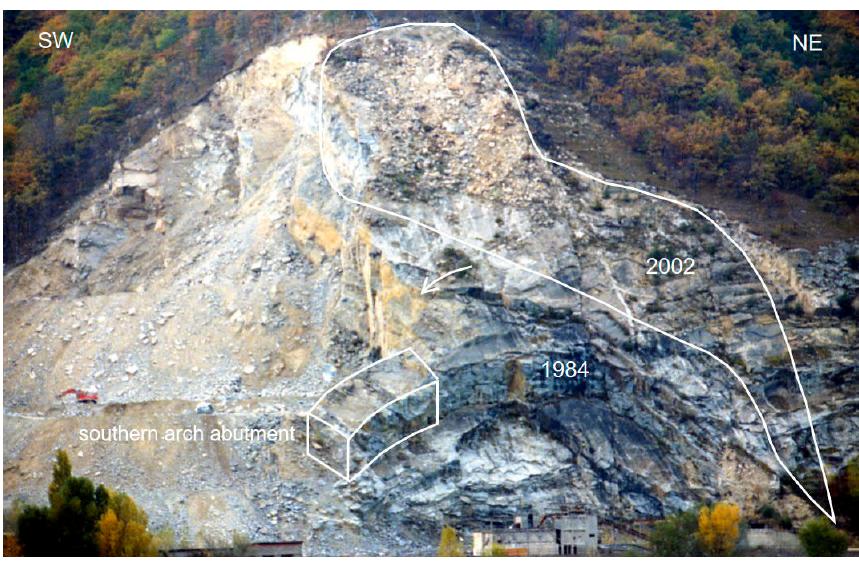
Figure 3. Detachments of rockslides on 4 October 1984 and on 11 October 2002.